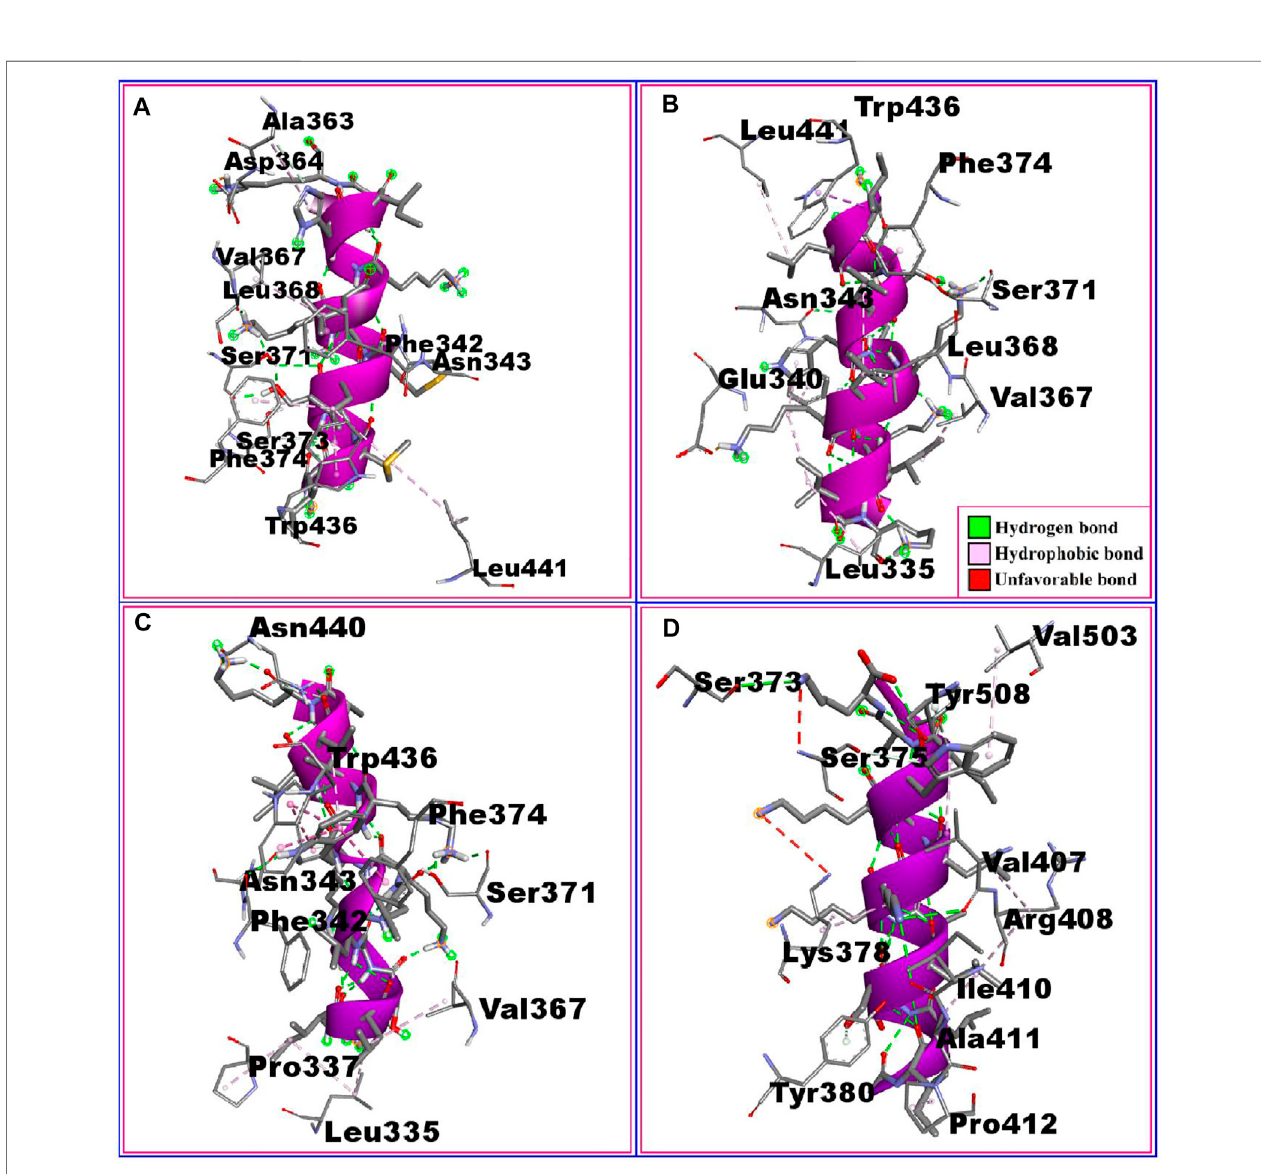
FIGURE 2 | The non-bonded interaction of the P2, P18, P20, P21 peptides and the RBD protein from SARS-CoV-2 at certain simulation times. Here, (A – D) , represents the binding interactions between the P2, P18, P20, P21 peptides and the RBD protein after 0ns of simulation time respectively.